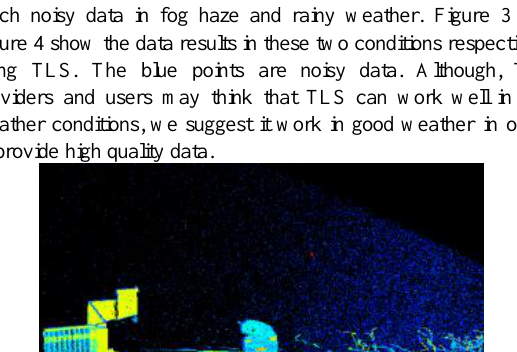
Fig.6 Field scanning photo in the east gate of Ta Keo